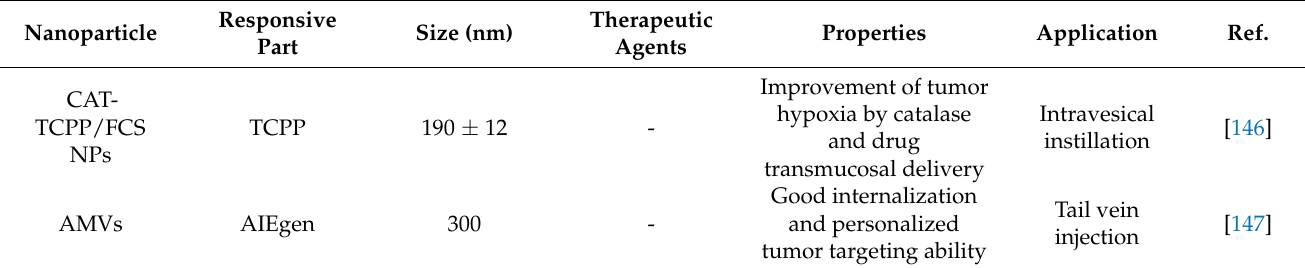
Table 8. Nano-formulations for sonodynamic